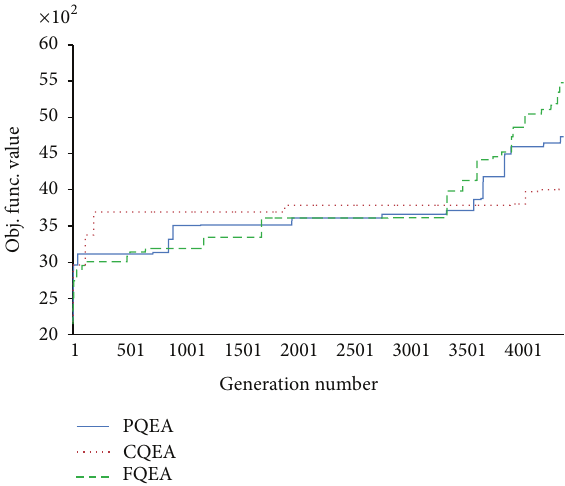
Figure 39: Convergence graph of PQEA, CQEA, and FQEA on 0-1 knapsack problem with circle data instances with number of items, 𝑀 , being 200 and capacity, 𝐶 , being 2% of total weight.